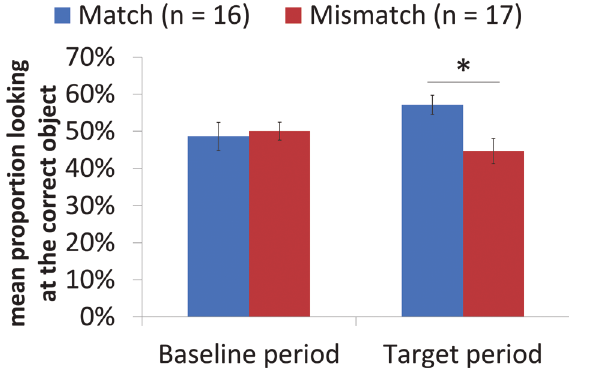
Fig 4. Mean proportion of time looking at the correct object in each time windows in the test trials. Calculation of baseline looking was the same as Fig. 3. Looking of Target window was calculated by averaging infants ’ looking at the target object from 400 ms to 2000 ms. The error bar indicates standard error.